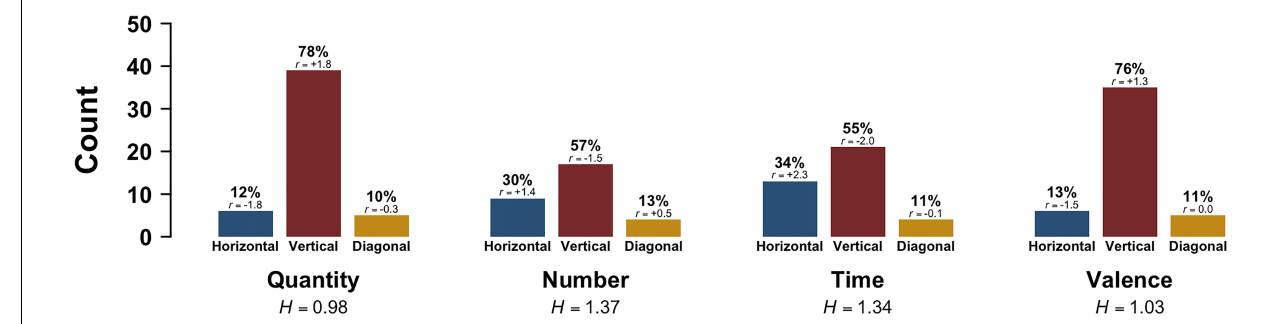
FIGURE 5 | Experiment 4: Dominant Orientation (horizontal, vertical, diagonal) as a function of Task; r indicates adjusted standardized Pearson residuals, which are based on the pooled data (participants contribute multiple data points), and H indicates Shannon entropy